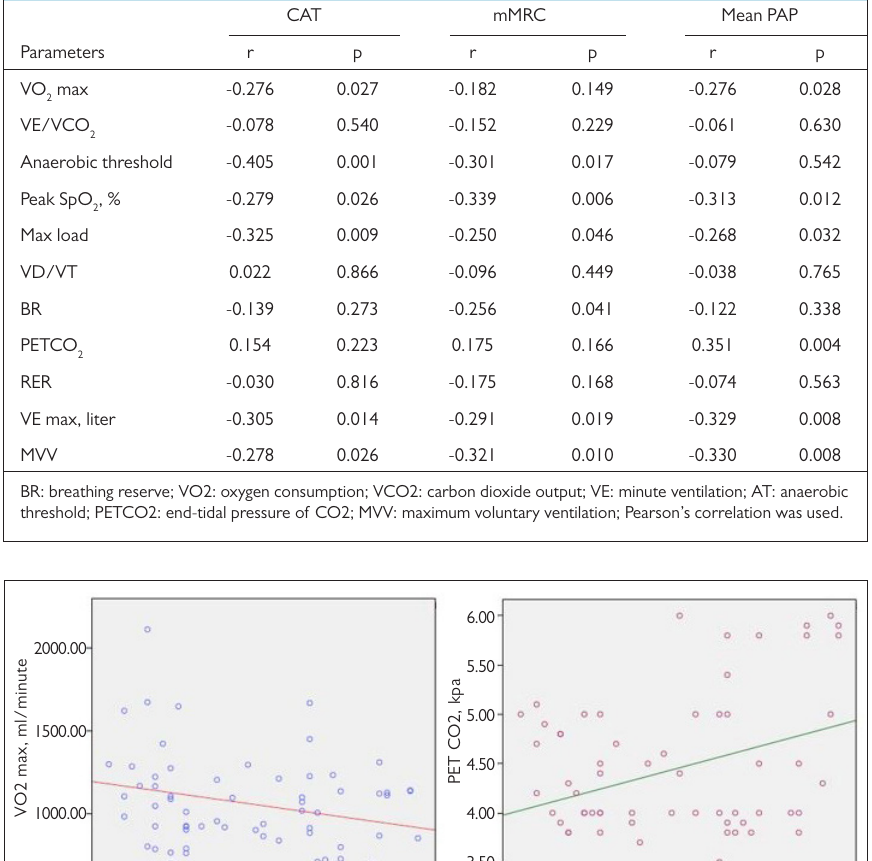
Table 3. Correlation between CPET parameters and CAT, mMRC, and mPAP